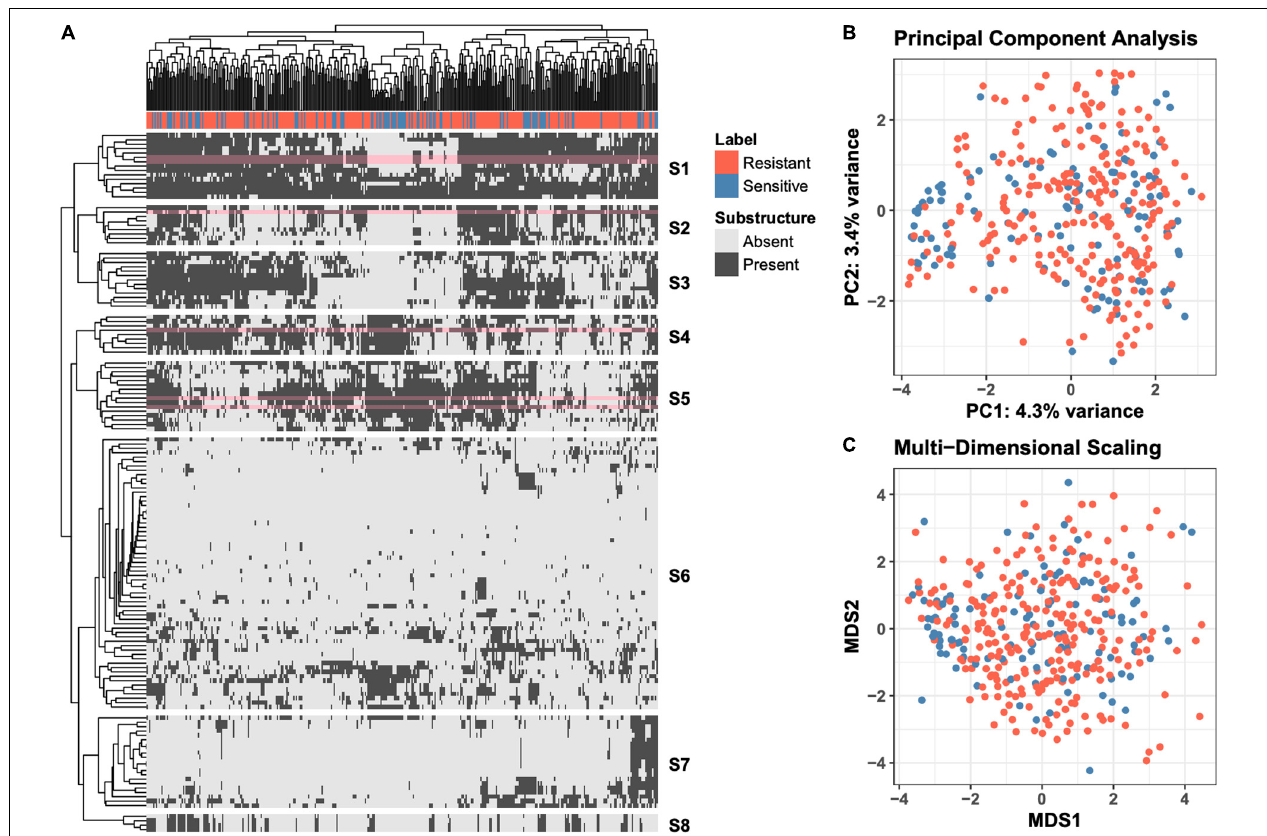
FIGURE 1 | Overview of the raw data. (A) Clustered heatmap of 149 substructure features (rows) computed across 376 drugs (columns). Individual entries in the heatmap denote presence or absence of a particular MACCS fingerprint in the corresponding drug. Orange labels indicate drugs that are more efficacious against ABC-16 yeast strain than the parental strain. Optimal leaf reordering was applied to both rows and columns in an effort to reveal additional structure in the data that may not be observed from the default ordering. The six substructures (rows) revisited in more detail in Figure 2 are highlighted in pink. (B) Projection of the raw data onto the first two principal components. The amount of variance explained by each component is displayed in the axis label. (C) Projection of the raw data onto the first two components of Multi-Dimensional Scaling. The coloring of points is consistent across all three